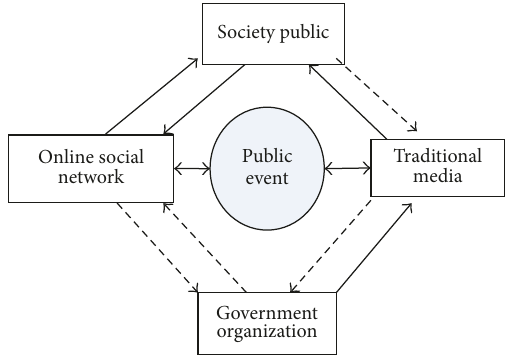
Figure 2: The propagation model of public event.